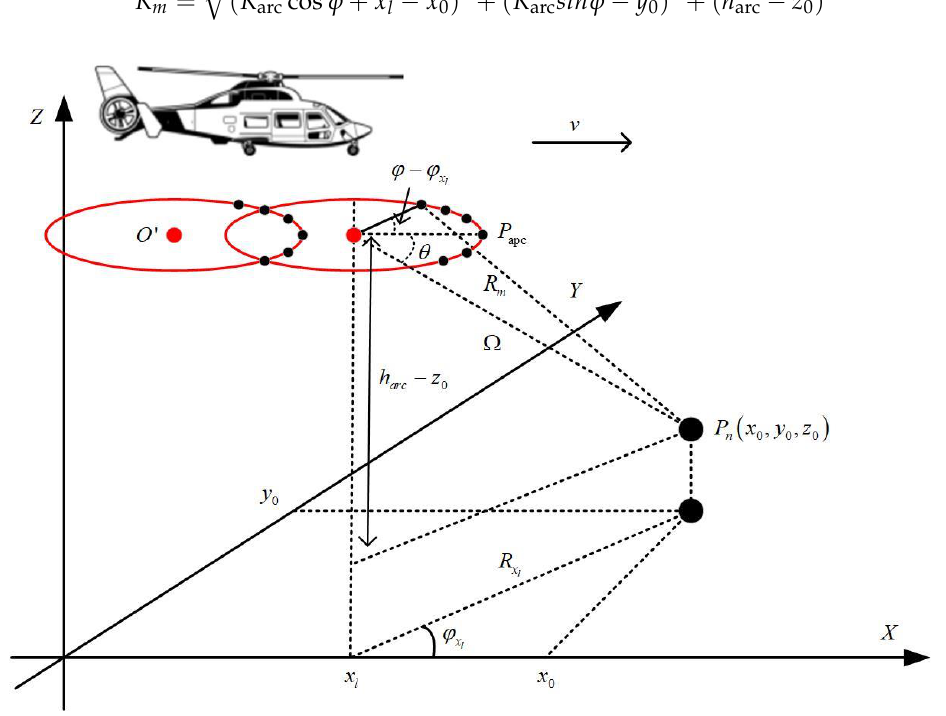
Figure 3. Azimuth section of AASAR in forward mode.